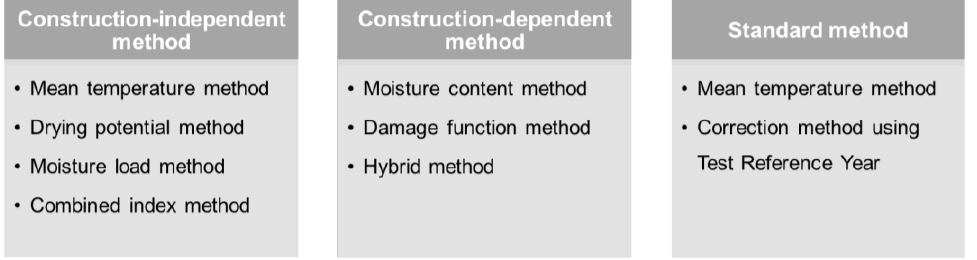
Figure 9. Three types of current methods to create Hygrothermal Reference Years.